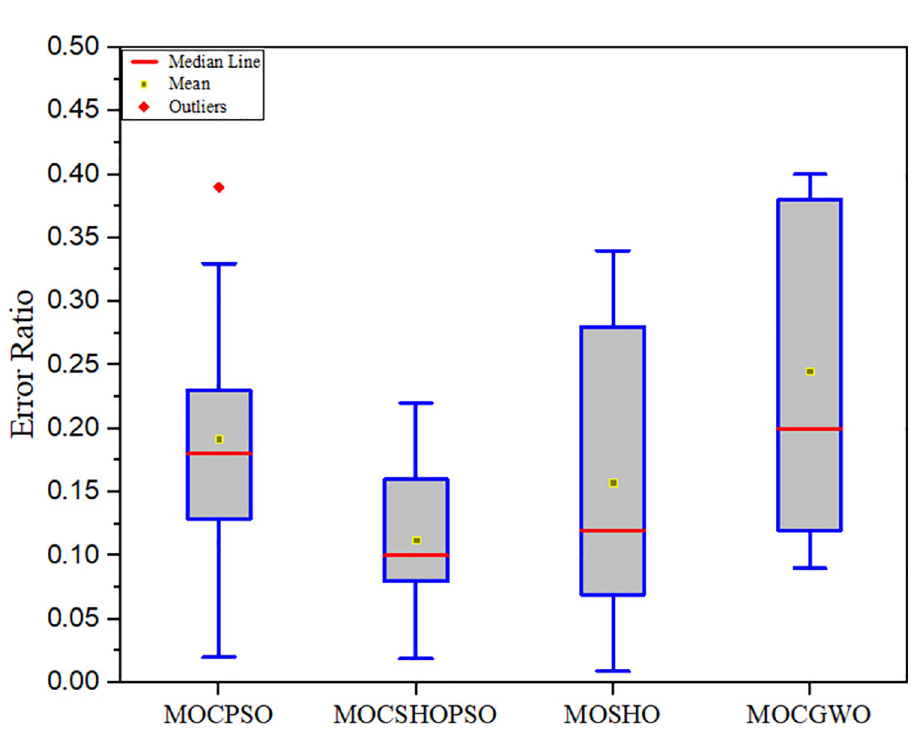
Fig 8. Box plot, driven from the error ratio comparison.